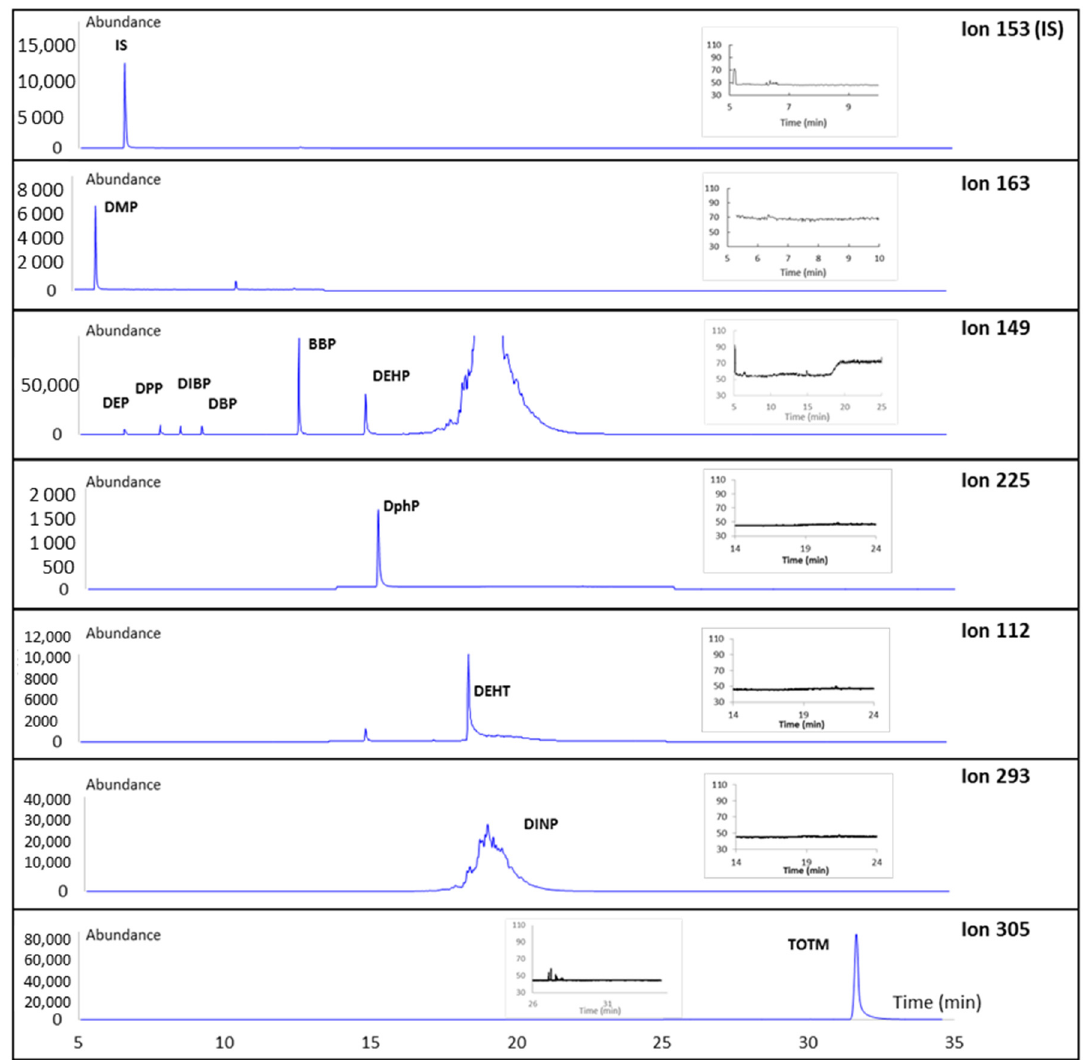
Figure 1. GC–MS chromatograms of plasticizers